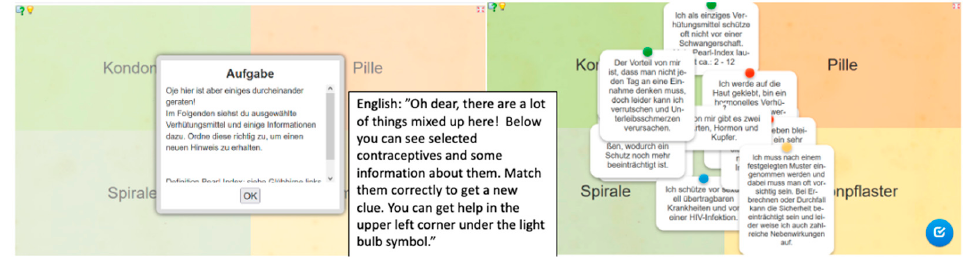
Figure 1. Characteristics of contraceptives .